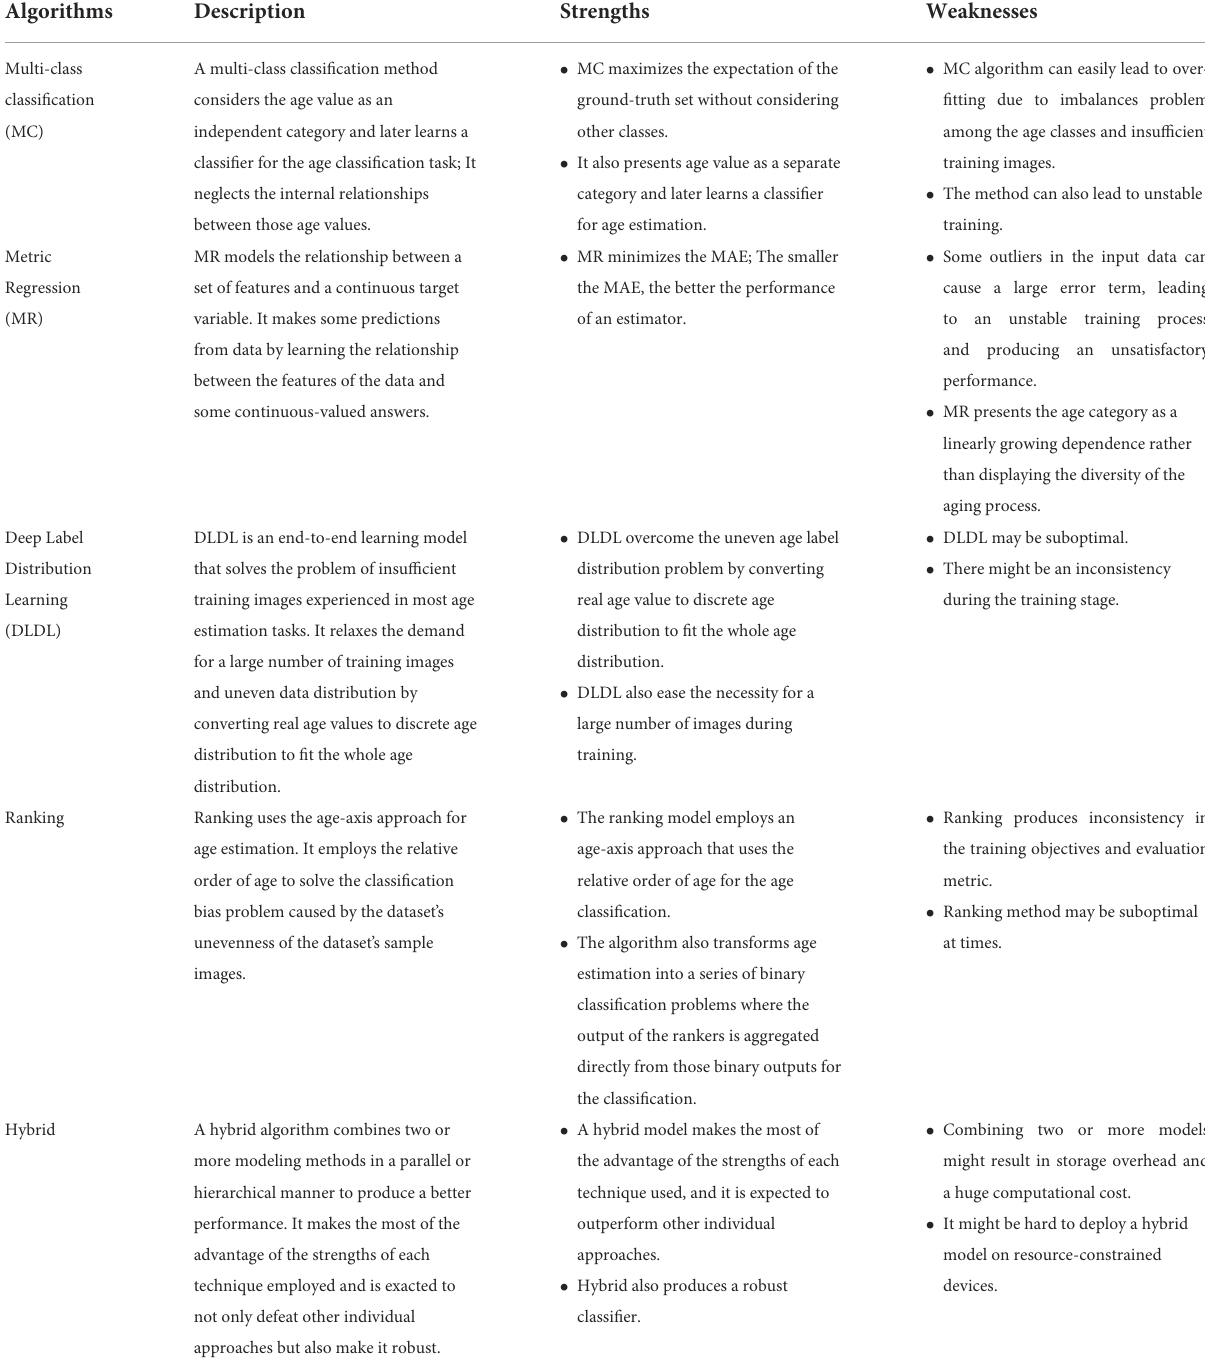
TABLE 1 Description of state-of-the-art algorithms in apparent age